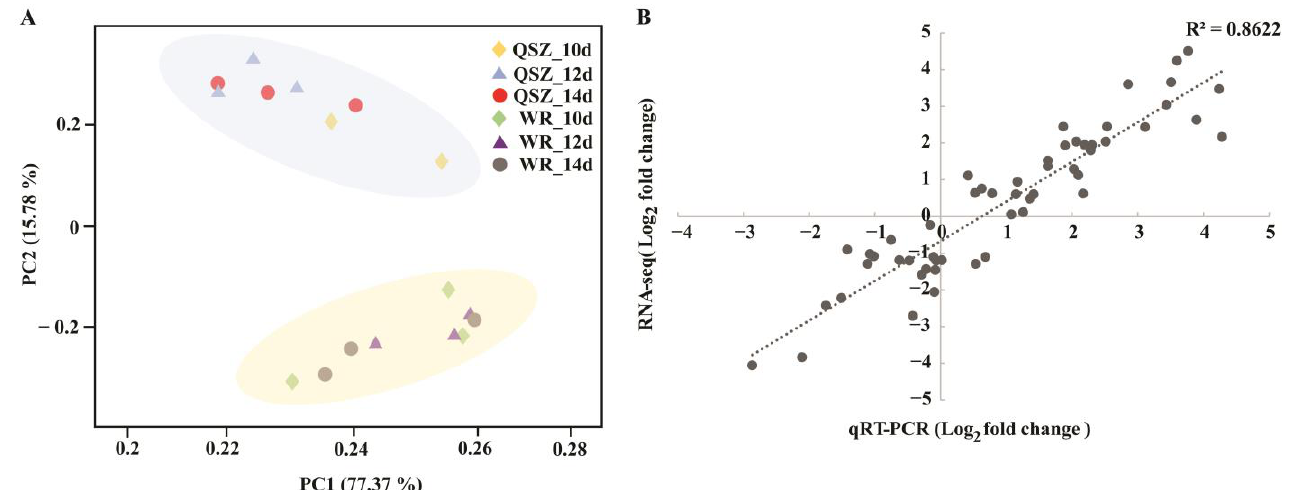
Figure 2. Evaluation of the reliability of RNA-seq data by PCA and qRT-PCR. ( A ) PCA of RNA-seq data of WR04-6 and QSZ under 10 °C for 10, 12 and 14 DAI. The X-axis represents the first principal component (PC1), and the Y-axis represents the second principal component (PC2). ( B ) Correlation between the log 2 fold change in qRT-PCR (WR04-6 vs. QSZ) and RNA-seq (WR04-6 vs. QSZ).